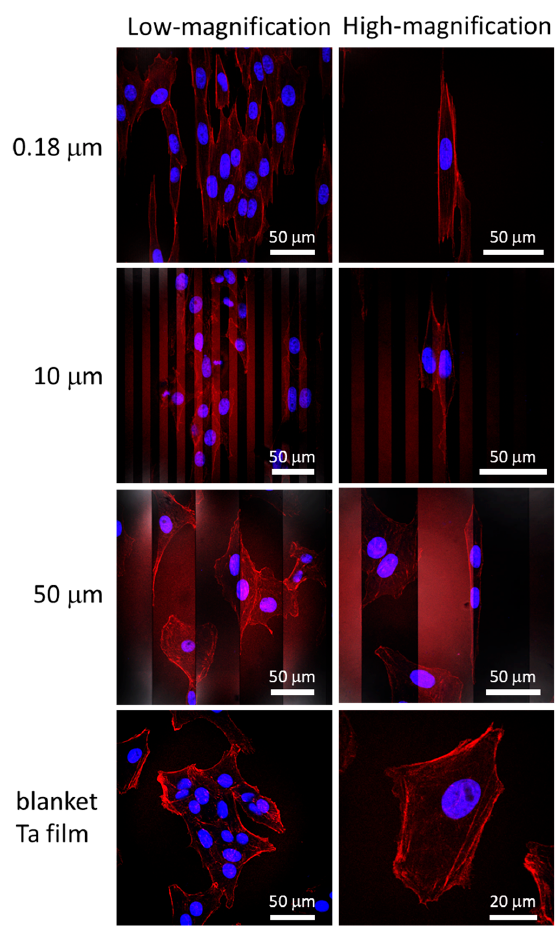
Figure 4. Typical fluorescence confocal micrographs of adherent cells on blanket Ta thin film and comb structures with line widths of 0.18, 10, and 50 μ m. Cell nuclei appear blue (4 ′ ,6-diamidino-2-phenylindole; DAPI), whereas F-actin microfilaments appear red (fluorescent phalloidin conjugate).